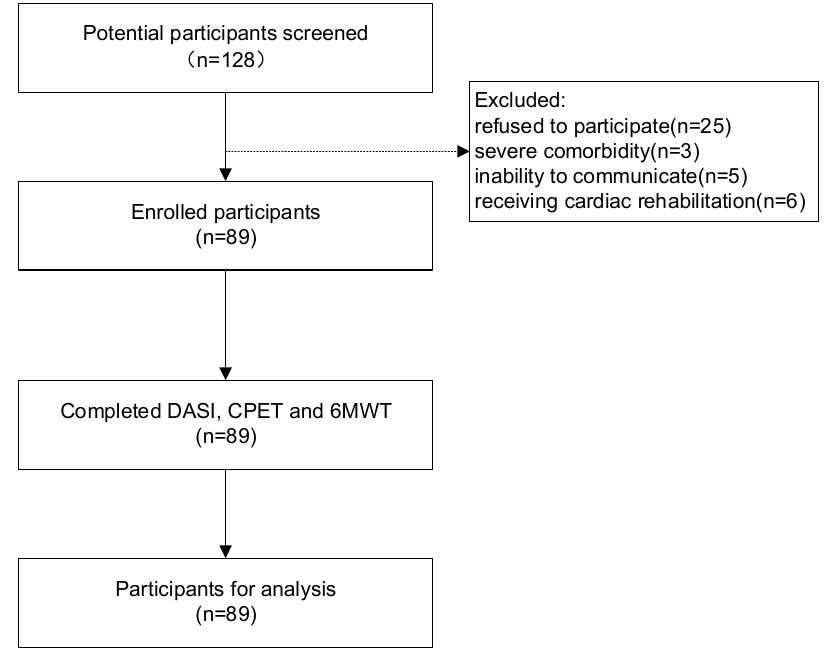
Figure 1. Flow diagram of the